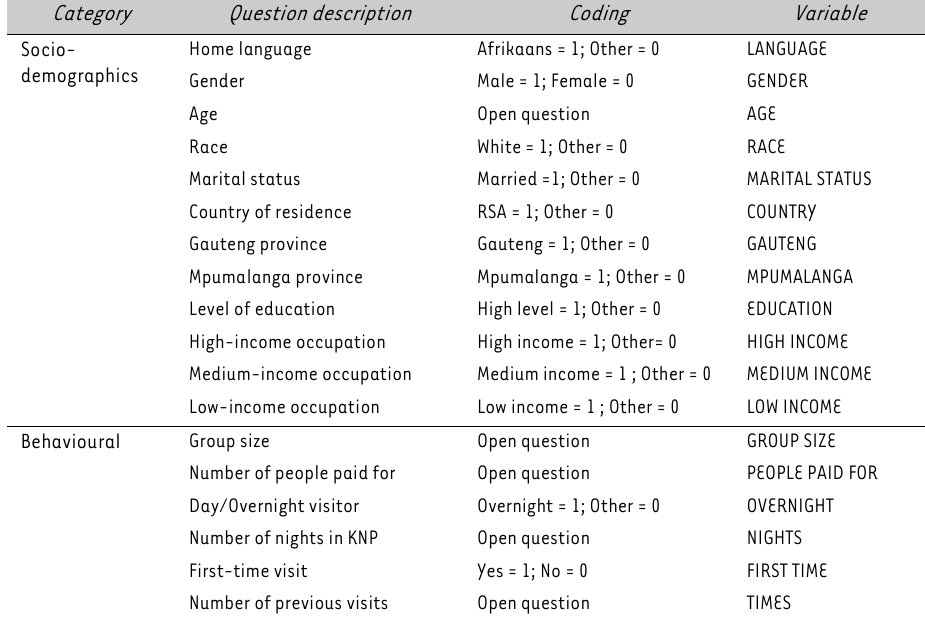
Questions used and their